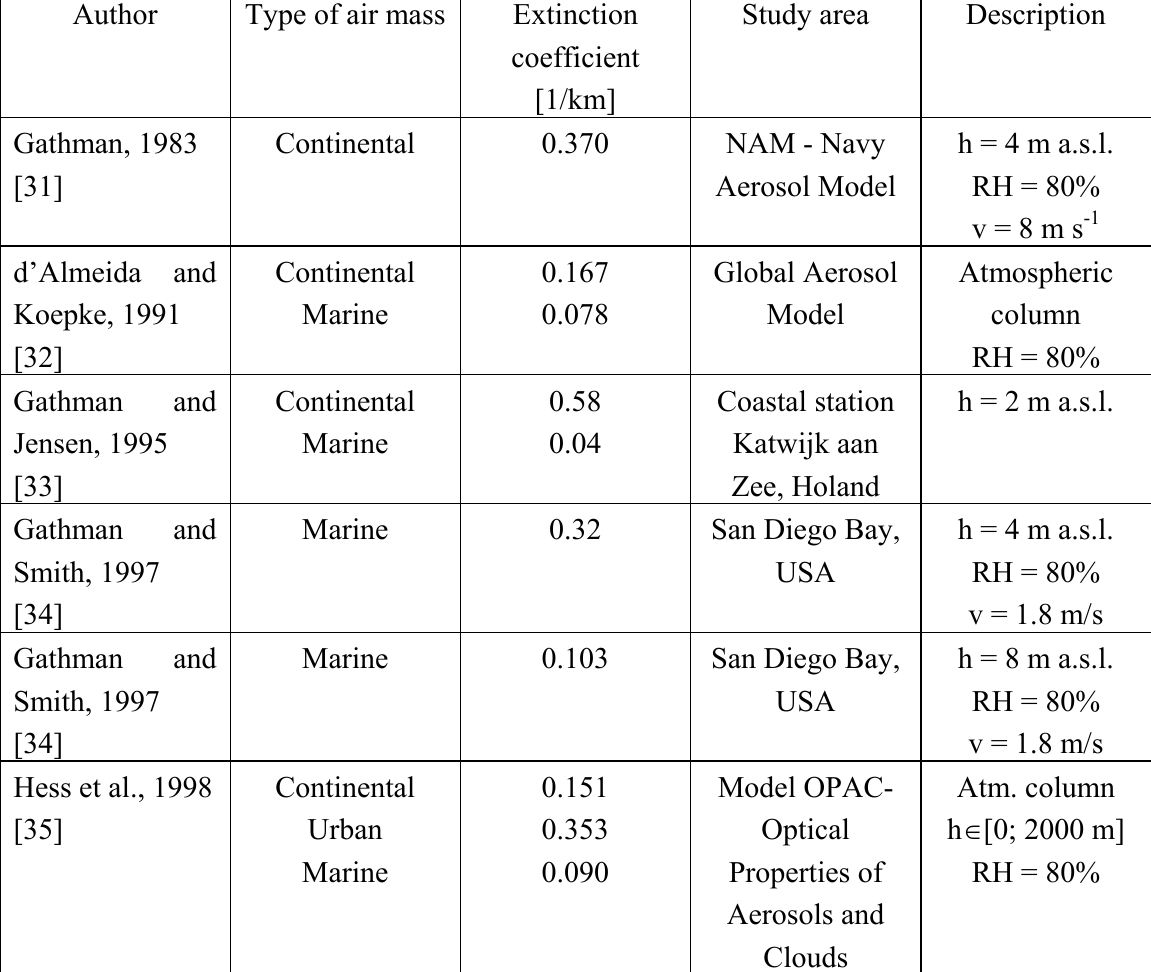
Table 6. Aerosol extinction coefficients obtained at λ = 550